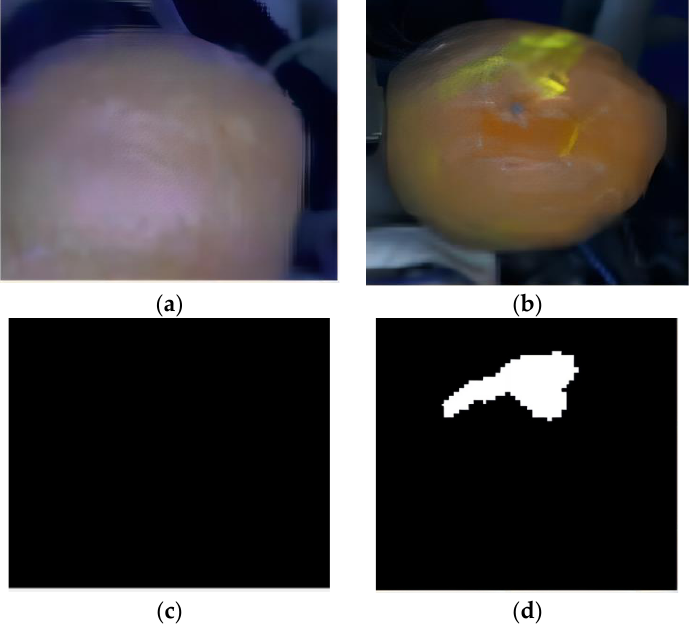
Figure 13. Binary images of citrus areas and defects part. ( a ) No defect citrus area. ( b ) Defective citrus area. ( c ) Binary image of the defective portion of a non-defective citrus region. ( d ) Binary image of the defective portion of a defective citrus region.